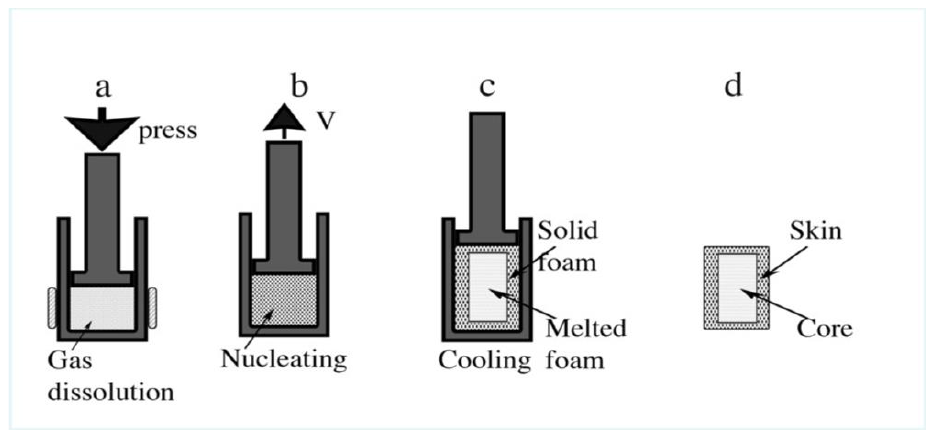
Figure 14. Schematic representation of the production of the foams. ( a ) melting of the polymer and decomposition of the azodicarbonamide, when the pressure stops increasing, the flask is released. ( b ) to carry out an adiabatic expansion and generate all the bubbles at the same time and fill the new volume. ( c ) the flask is stopped, and the mold is cooled down after a certain time, but due to the thermal conductivity of the porous material, the inner part still melts and allows higher coalescence in the core of the foams. ( d ) the final cylindrical sample had two different parts, but without a hard change, is gradually for the small pores in the skin to become a larger in the core of the samples.